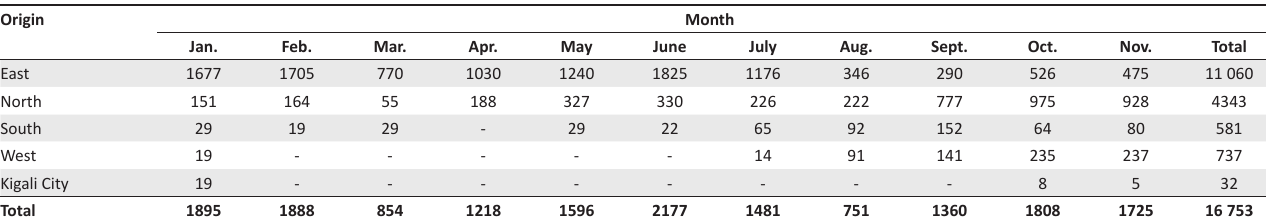
TABLE 1: Origin of slaughtered animals.